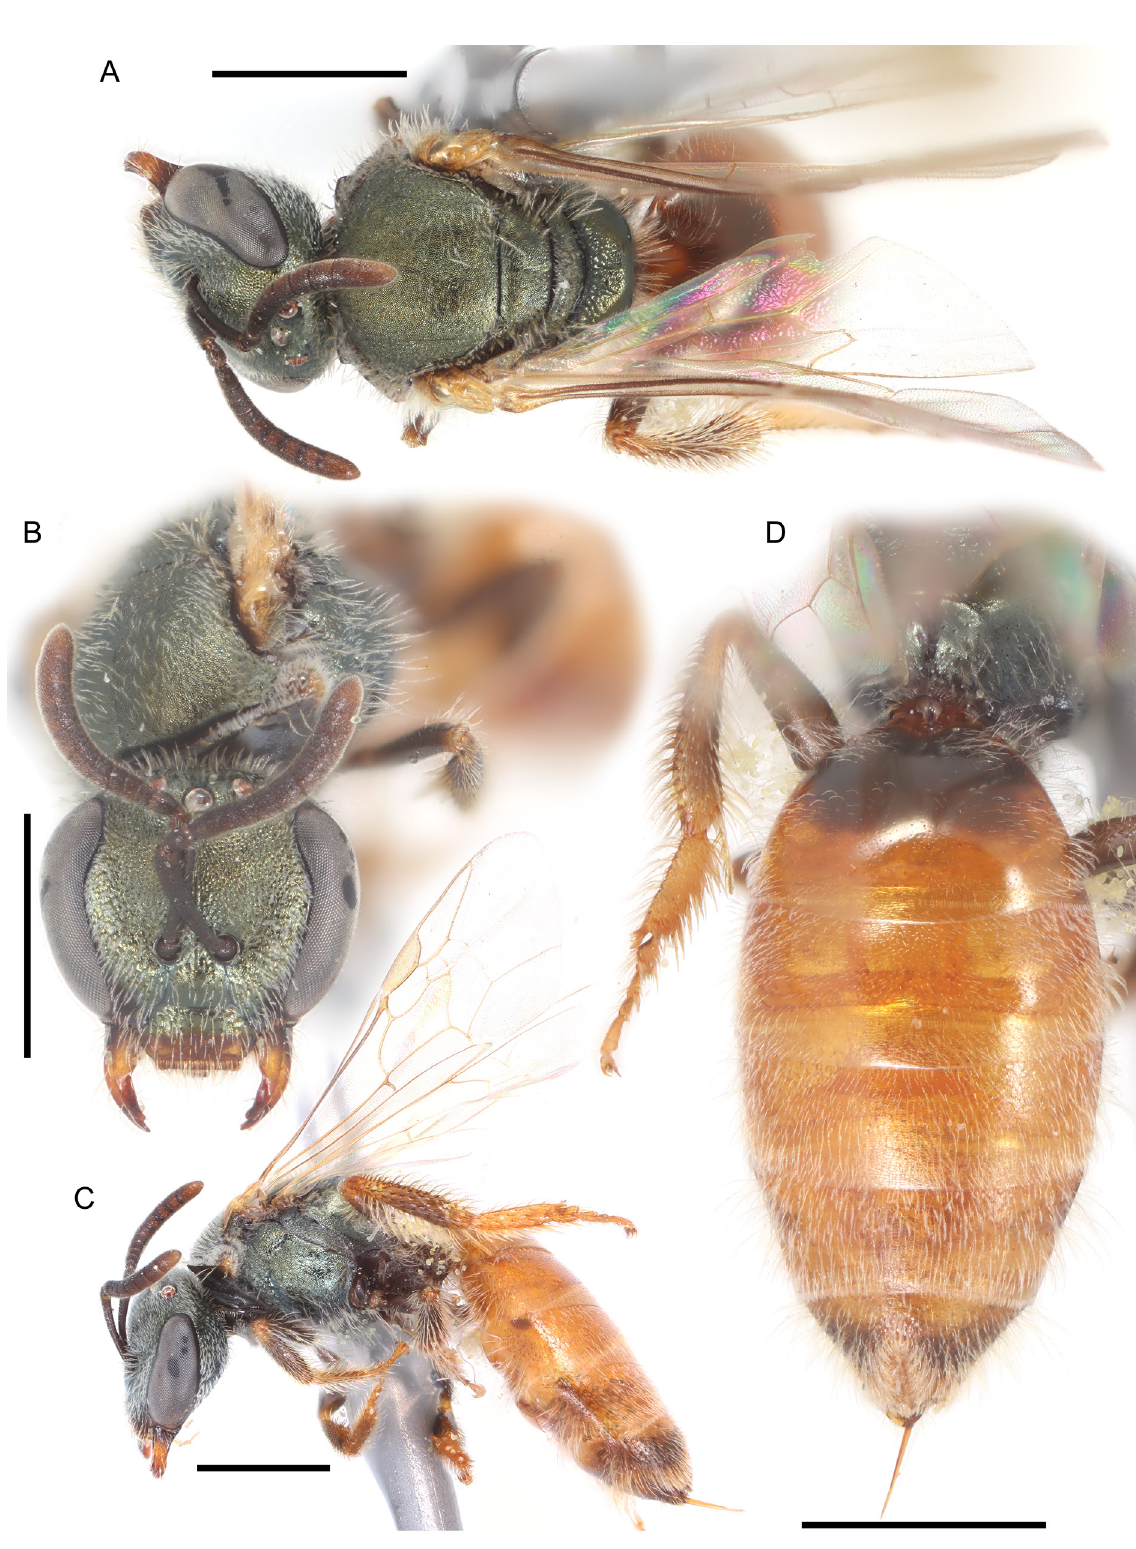
Fig. 81. Lasioglossum ( D. ) tessellatosum sp. nov., ♀. A . Dorsal habitus. B . Face. C . Lateral habitus. D . Propodeum and metasoma. Scale bars: 1